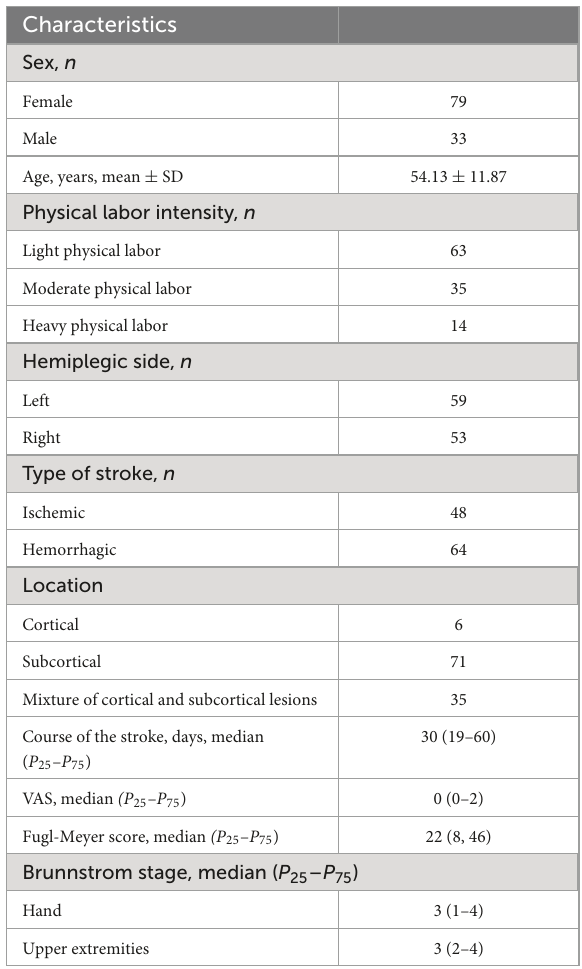
TABLE 1 Patients’